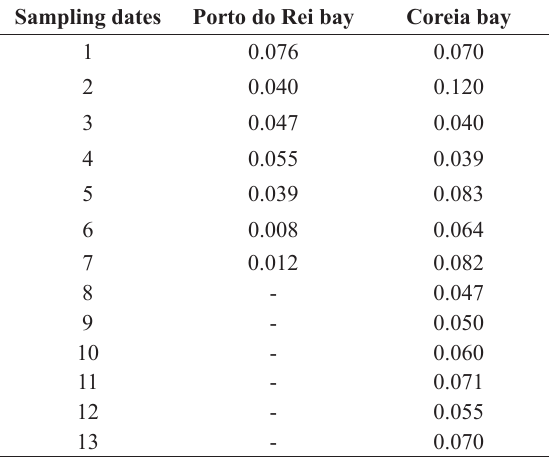
Current velocity (m s -1 ) at the control points located 100 m away from the pens at the Porto do Rei and Coreia bays on different sampling